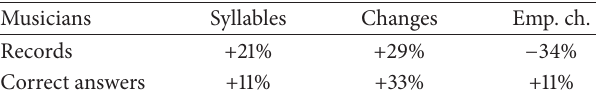
Table 11: Table of records and correct answers differences between musicians and nonmusicians. Musicians Syllables Changes Emp. ch. Records +21% +29% − 34% Correct answers +11% +33%